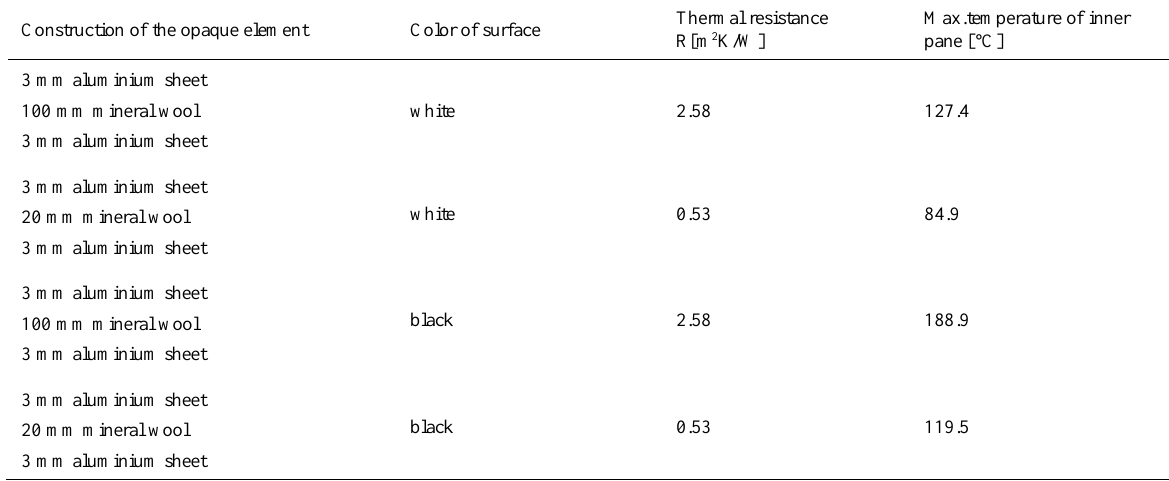
Table 1: Example of the influence of the color of the surface in shadow